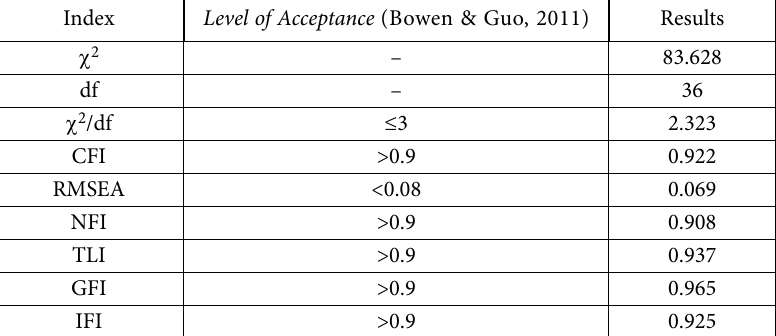
Figure 2. Structural model of the relationships between ESG factors and EVA Table 3. Goodness-of-fit indices for the structure model between ESG factors and